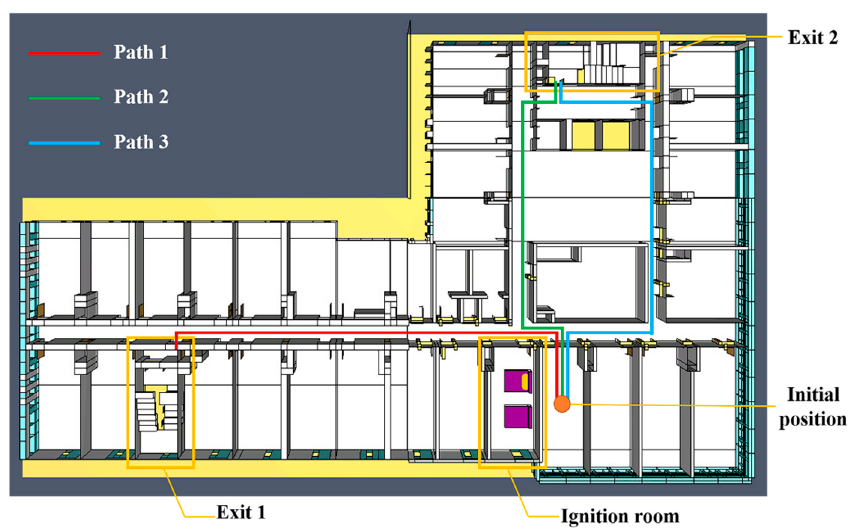
Figure 6. Evacuation scene.